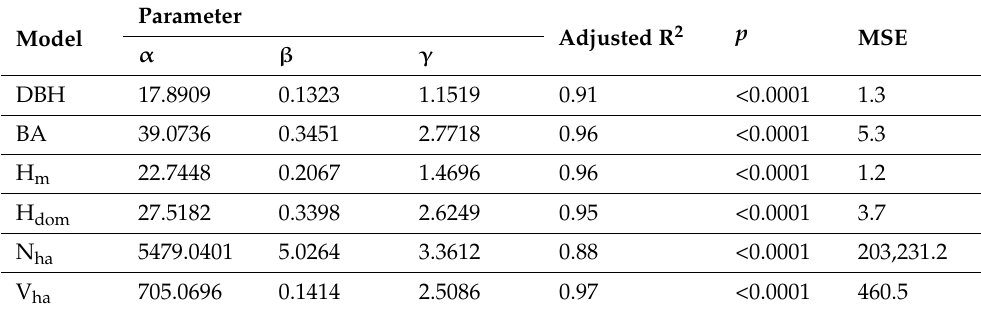
Table 3. Parameters and R 2 of stand growth equations for an Acacia hybrid plantation in Vietnam. Model